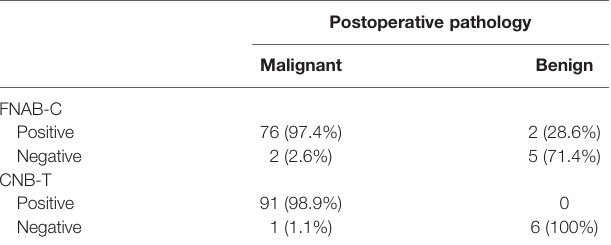
TABLE 3 | Diagnostic performance of between FNAB-C and CNB-T.